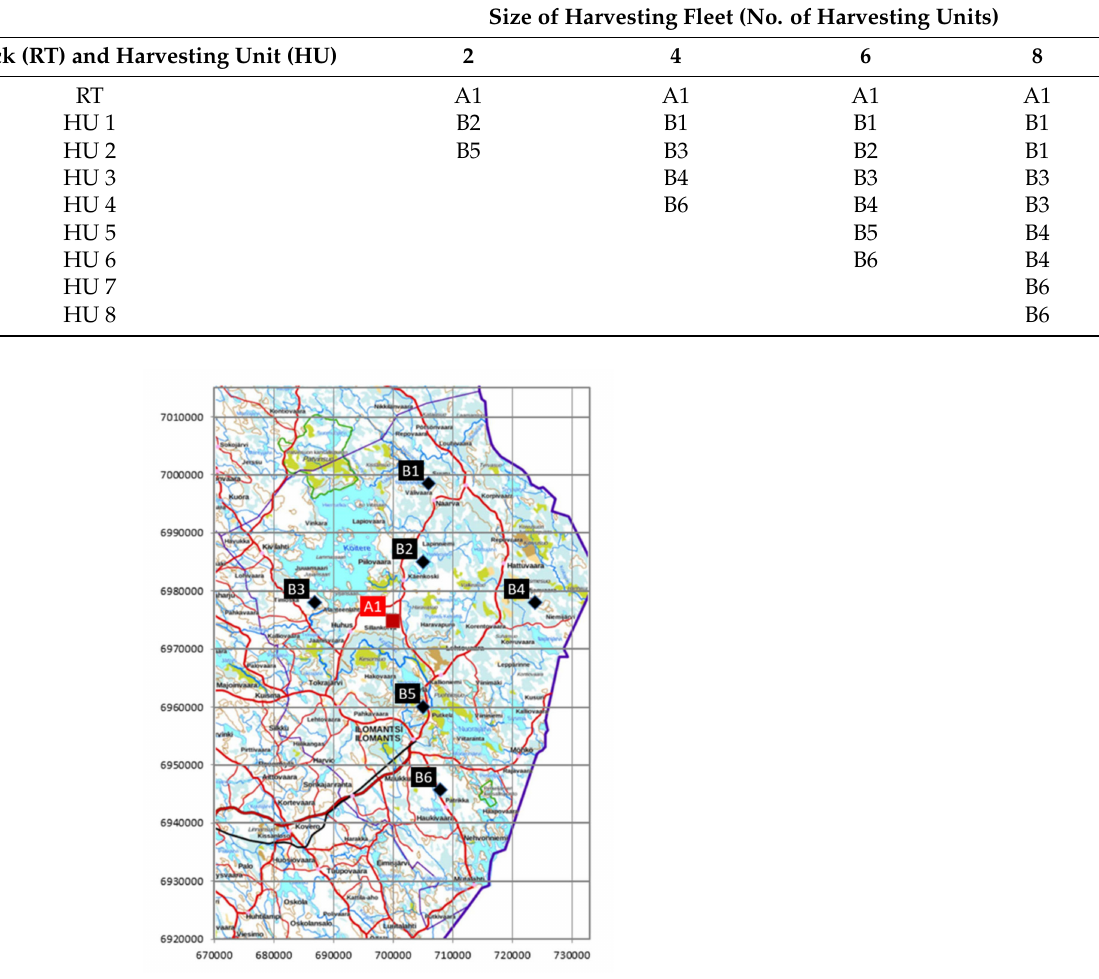
Table 5. Base locations of machine/truck operators, harvesting units, and a relocation truck in the case harvesting area. The codes of locations are given in Figure 4.